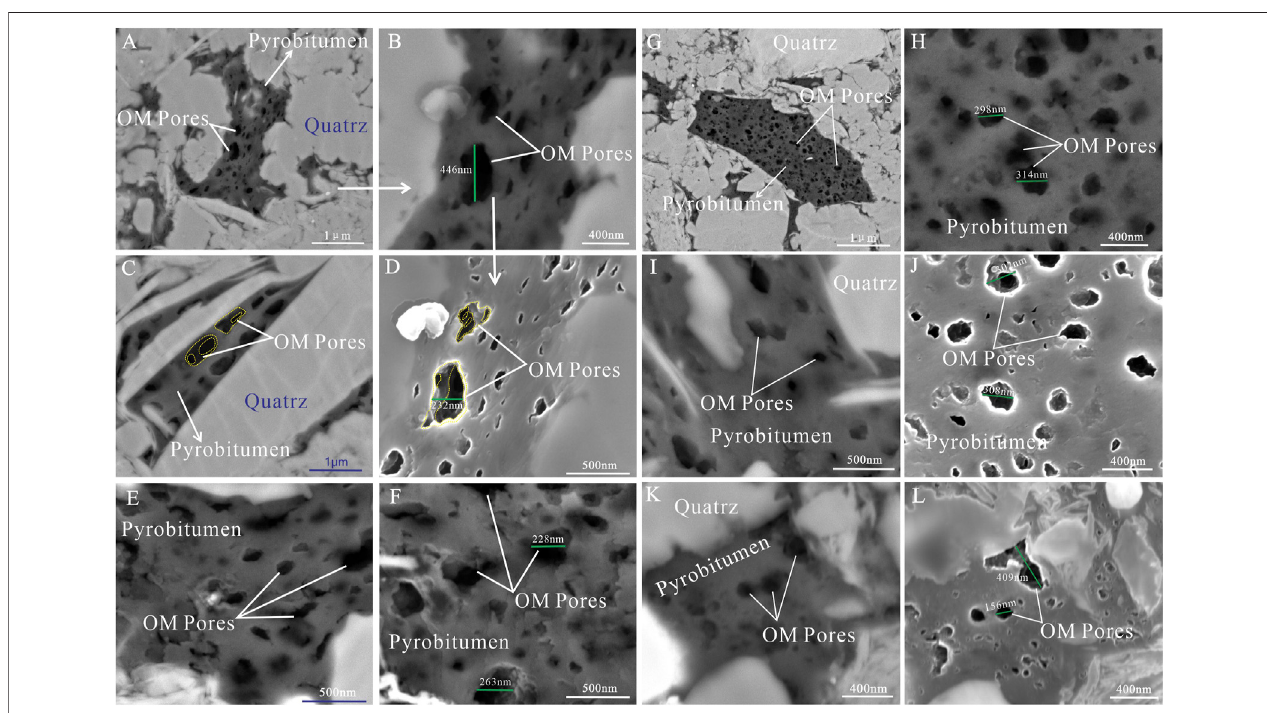
FIGURE 7 | OM pore characteristics of the Longmaxi shale samples from Chongqing (YC4 well, 774 m and JY1 well, 2405 m, G-H, J, YC4 well, 756 m; I, L, JY1 well,2405 m).AlargenumberofOMporeswithlargesize(100 – 500 nm)areseeninpyrobitumen.OMporesaremostlyroundandovalinshape. (A,B) wererevisedfrom Wang et al. (2016a). (E,F) were revised from Wang et al., 2020). OM pores with small size are nested in larger OM pores. (G,J) were revised from (Wang et al., 2020).